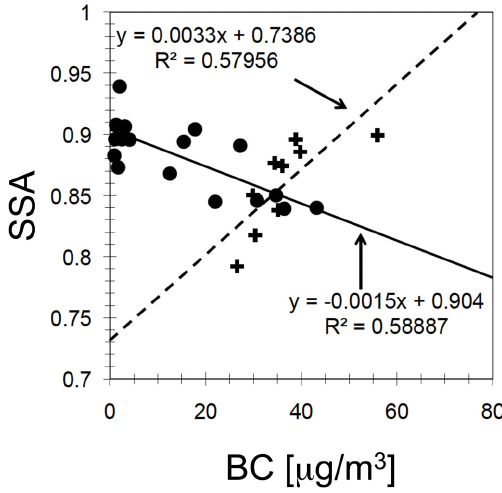
Fig. 7. As in Fig. 6, but for SSA.